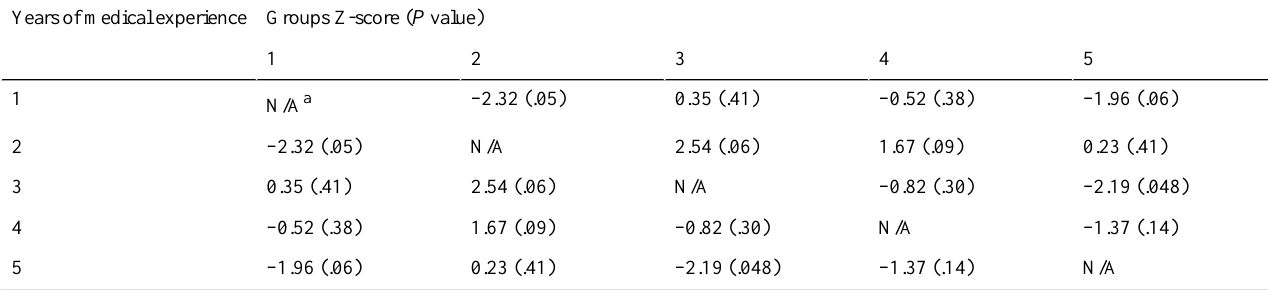
Table 4. Dunn test results comparing participants’years of medical experience between the groups.